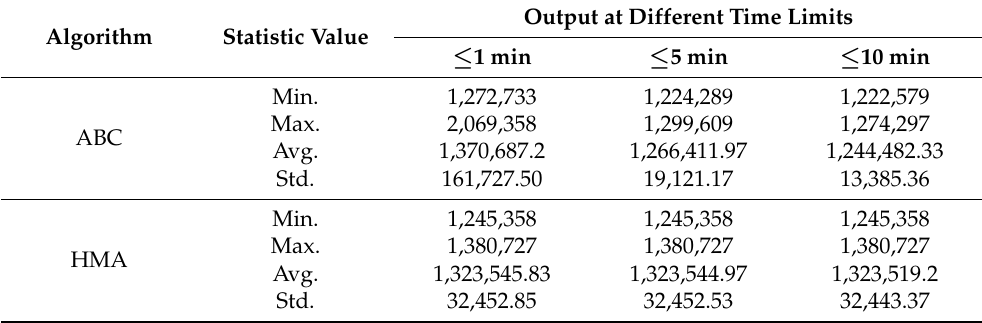
Table 5. Statistics of the total cost of the globally best solution of the HMA and the ABC algorithms on the “egl-g1-A” instance, within different time limits.